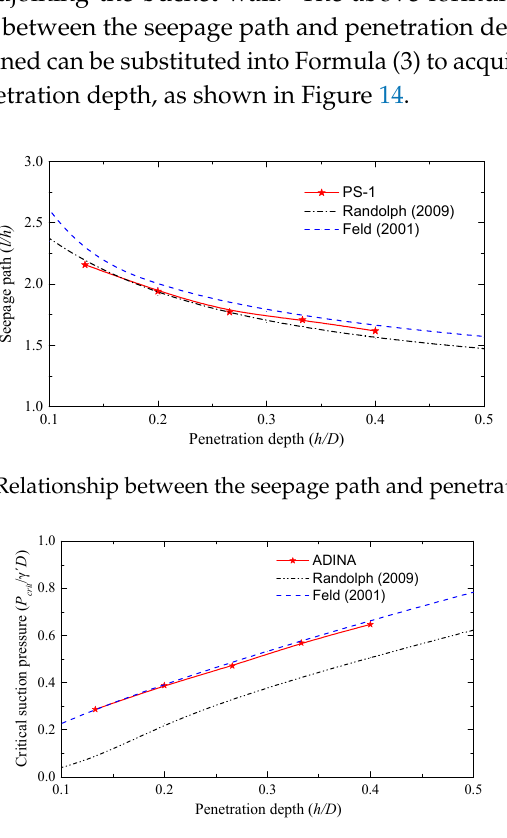
G F C H JD E IGFC Figure 15. Relationship between the seepage path and penetration depth.